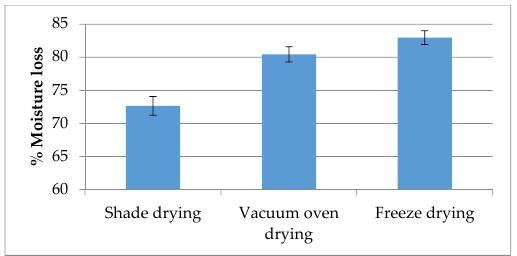
Figure 1. Effect of different drying methods on moisture loss in Z. officinale var. rubrum Theilade. Bars represent standard error of the